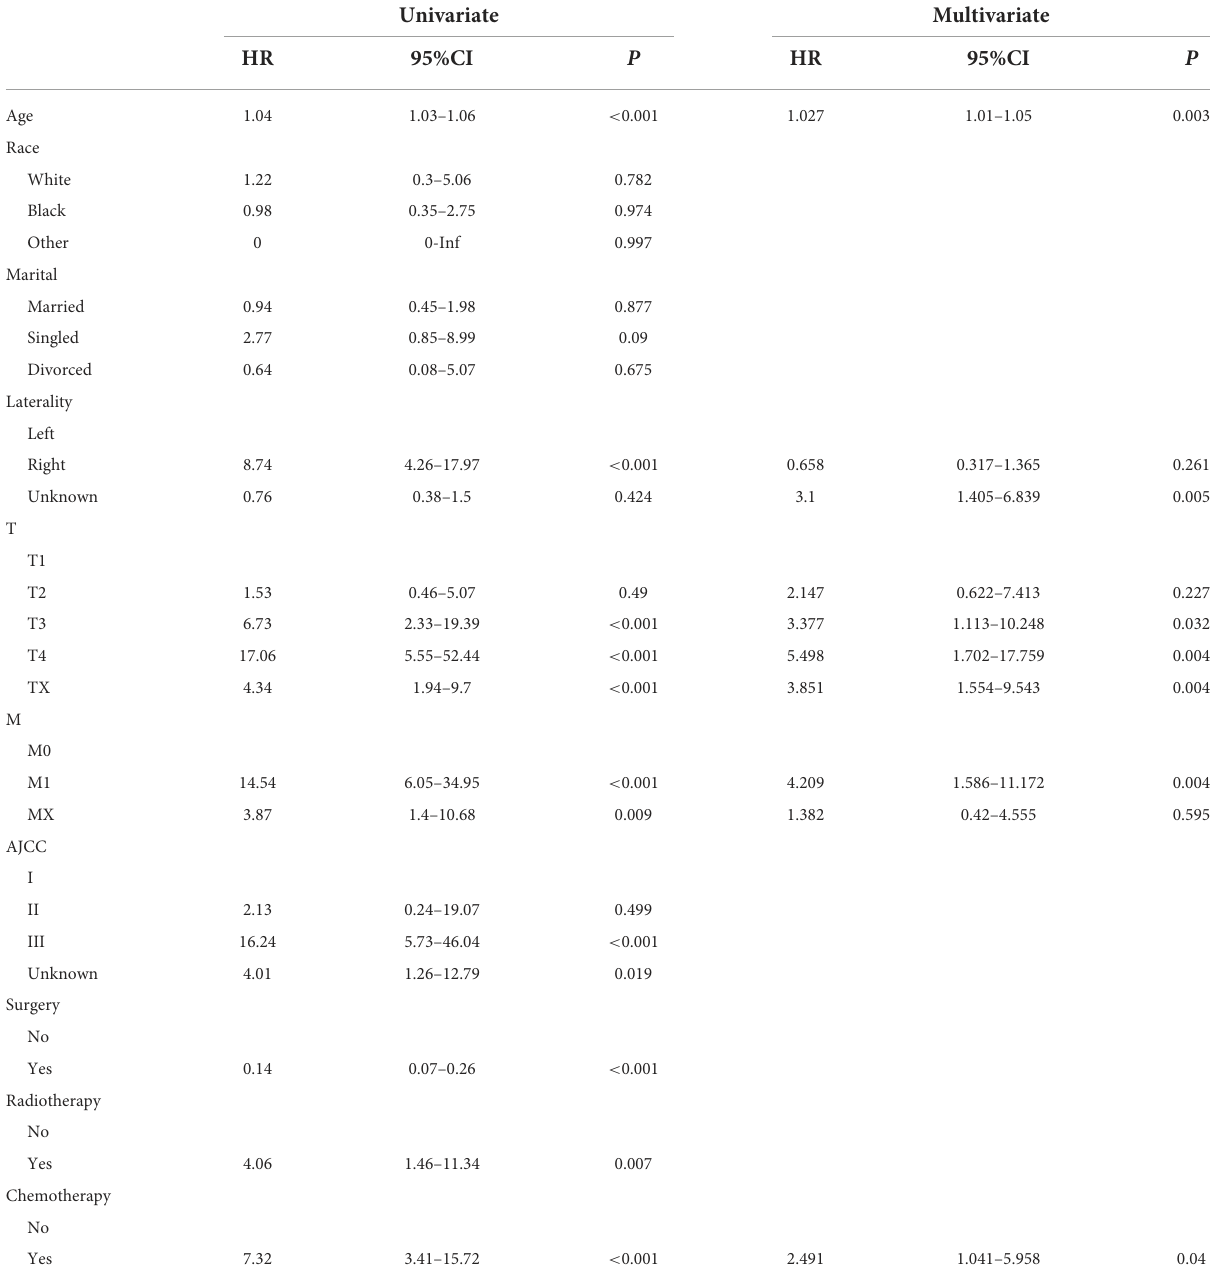
TABLE 2 Univariate and multivariate analyses of CSS in training set. Univariate